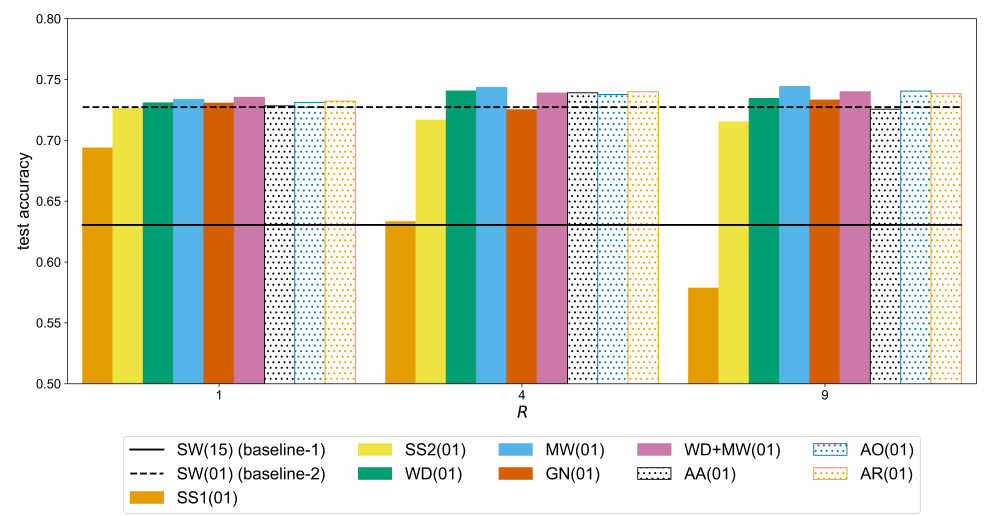
Figure A4. Average test accuracy of AtzoriNet* for each method at different augmentation ratios, R , for the Ninapro-DB1 dataset. The solid line corresponds to τ = 15 and the dashed line to τ = 1 (see also Figure A3).